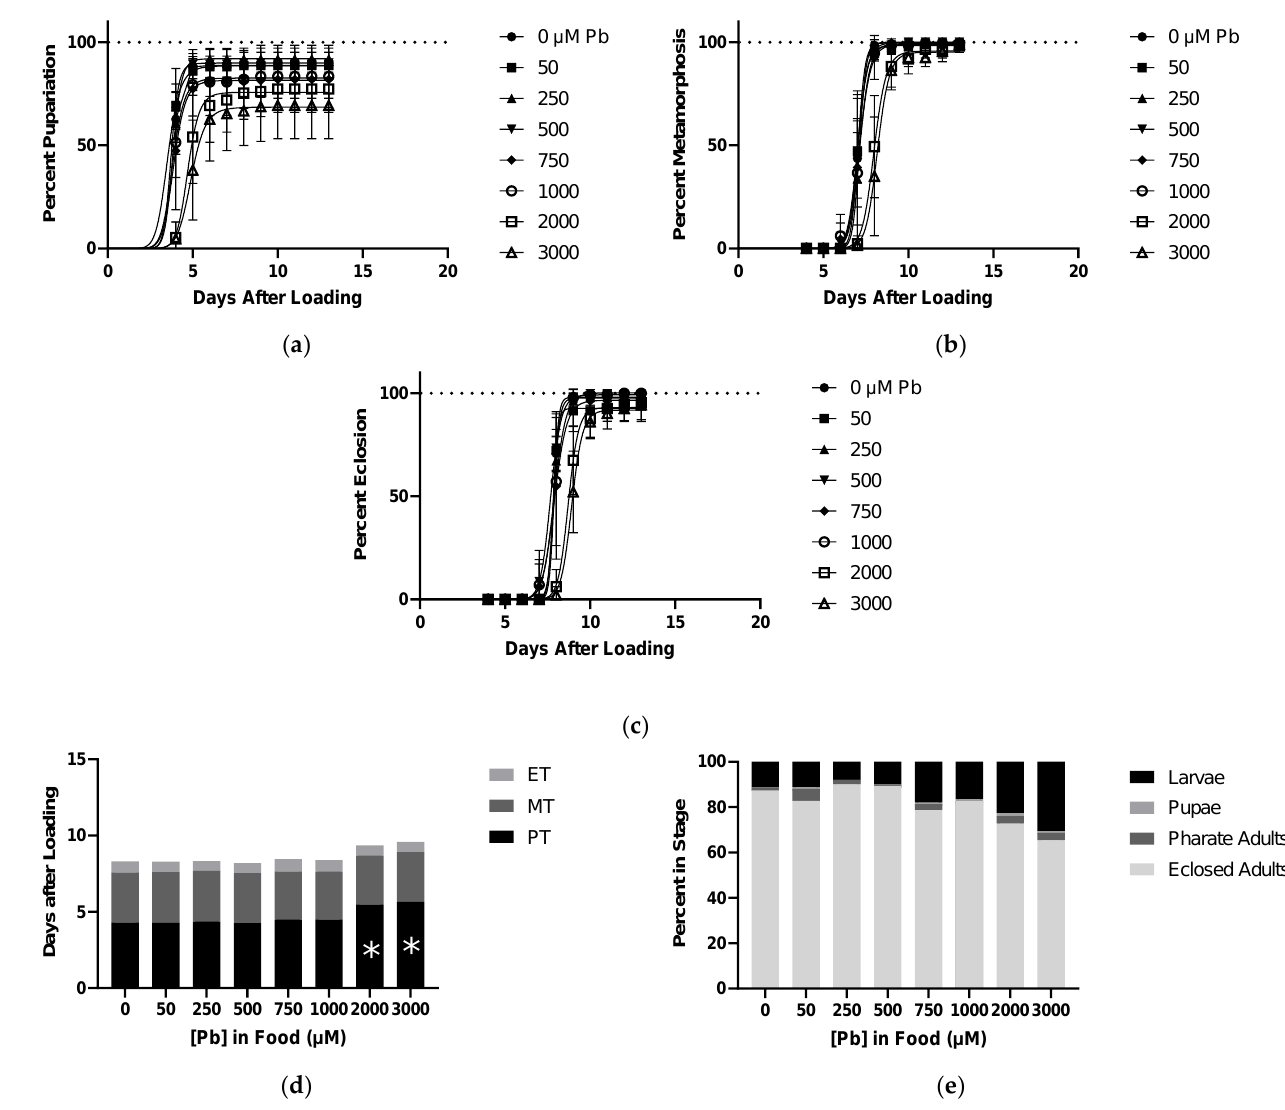
Figure 4. Effects of Pb on Developmental Time Course. All data from same experiment using CS larvae dosed with indicated concentrations of Pb in food. ( a ) Pupariation: pupae formation rates of larvae after being loaded onto food. ( b ) Pupa Metamorphosis: pharate adult formation rates of pupae standardized to total pupae formed. ( c ) Pharate Adult Eclosion: rate of eclosion standardized to total number of individuals completing metamorphosis. ( d ) Developmental Timing: representation of time spent in each stage derived from data shown in 1a – c. This allows for accounting of delays seen in later stages caused by carryover of pupariation delays. ( e ) Developmental Endpoints: representation of individuals in each stage at the defined endpoint of 13 days from 1a – c. Individuals that are not eclosed adults correspond to a lethality during development. (* p < 0.05 compared to 0 µM, two-way ANOVA)